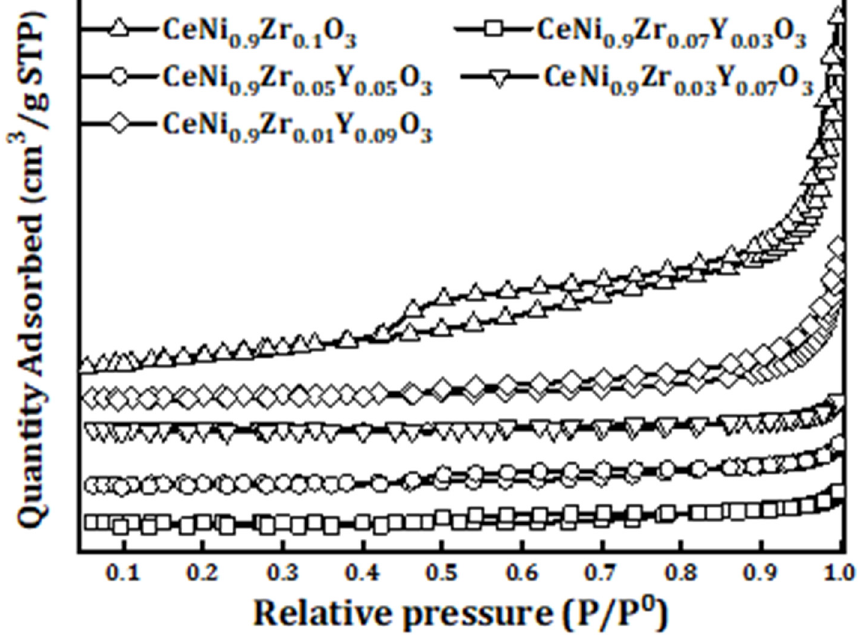
Figure 1. Nitrogen physisorption isotherms of perovskite catalyst CeNi 0.9 Zr 0.1 − x Y x O 3 ( x = 0, 0.03, 0.05, 0.07, and 0.09).